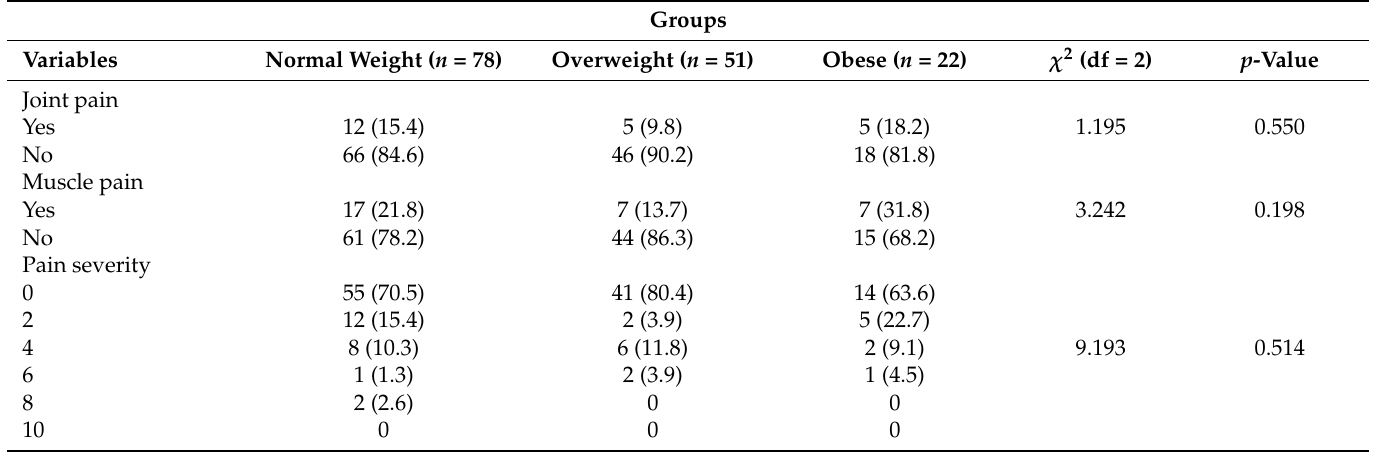
Table 4. Comparison of musculoskeletal complaints among normal-weight, overweight and obese girls. Groups